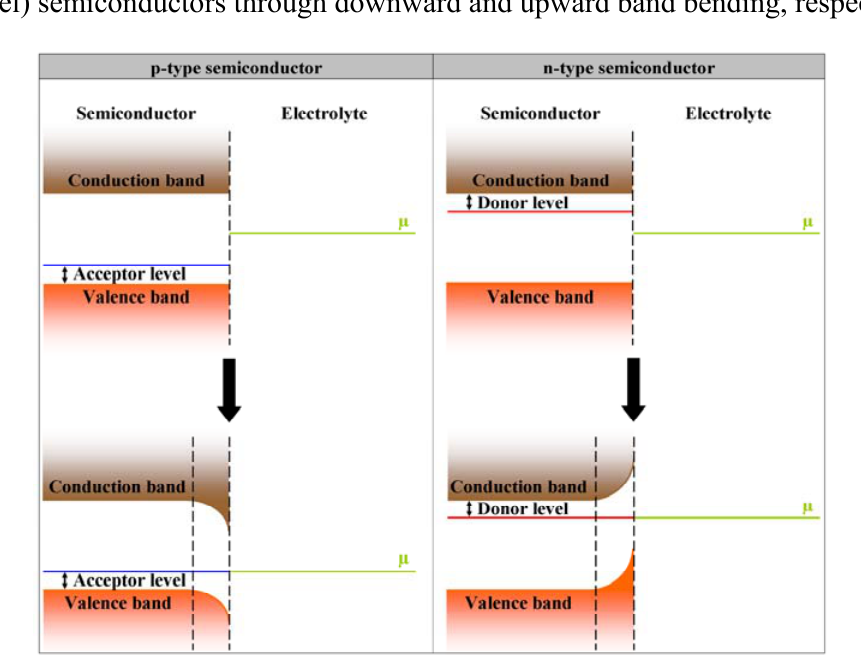
Figure 12. Generation of thermodynamic equilibrium in p-type (left panel) and n-type (right panel) semiconductors through downward and upward band bending,